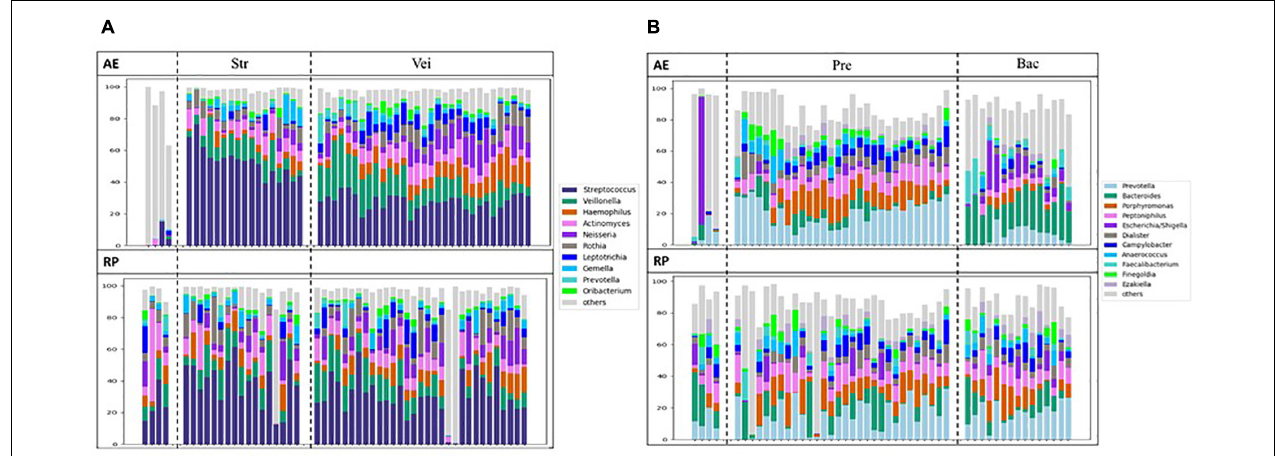
FIGURE 5 | Changes of microbial compositions in (A) throat and (B) stool samples moving from AE (top) into RP